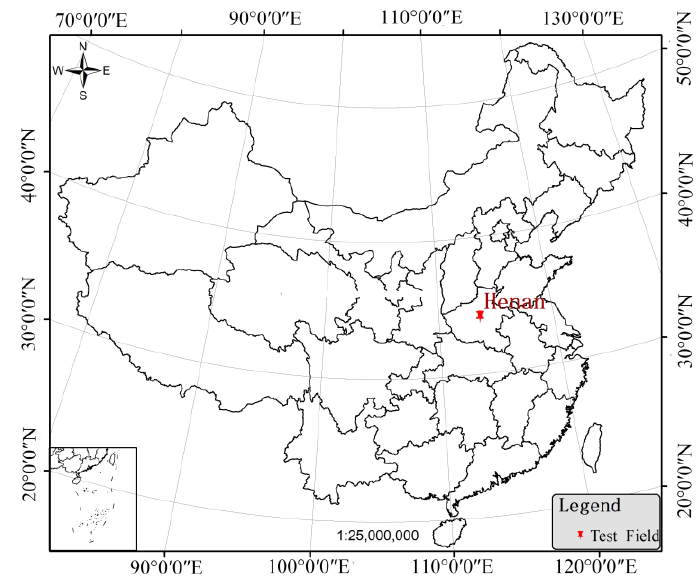
Figure 1. Location of the one specific synthetic aperture radar geometric calibration field in Henan province, China.